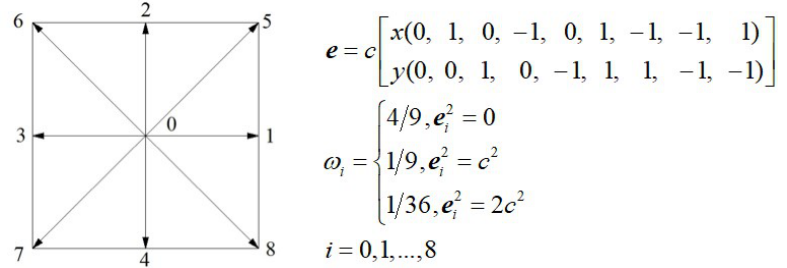
= 1 is the lattice velocity, t